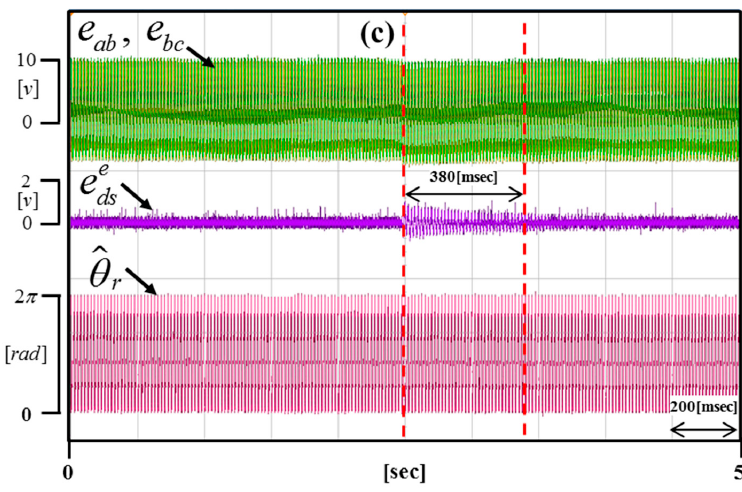
Figure 19. Enlargement of the portion in Figure 16c.